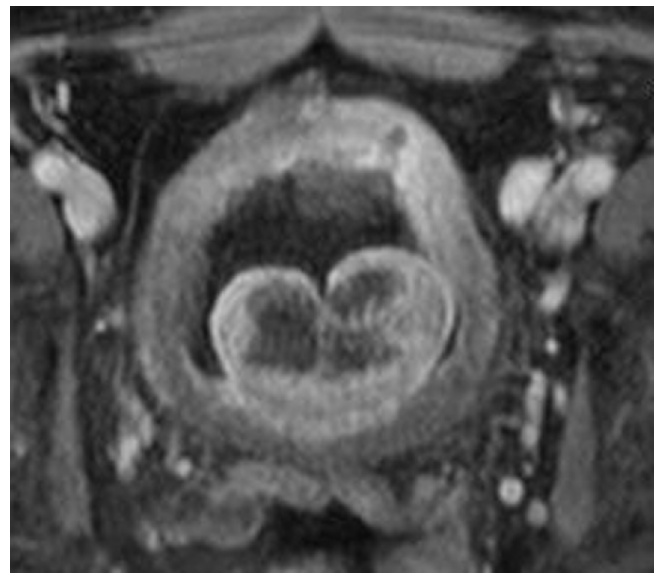
FIGURE 2. Axial, post-treatment MRI of large middle lobe, demonstrating gadolinium